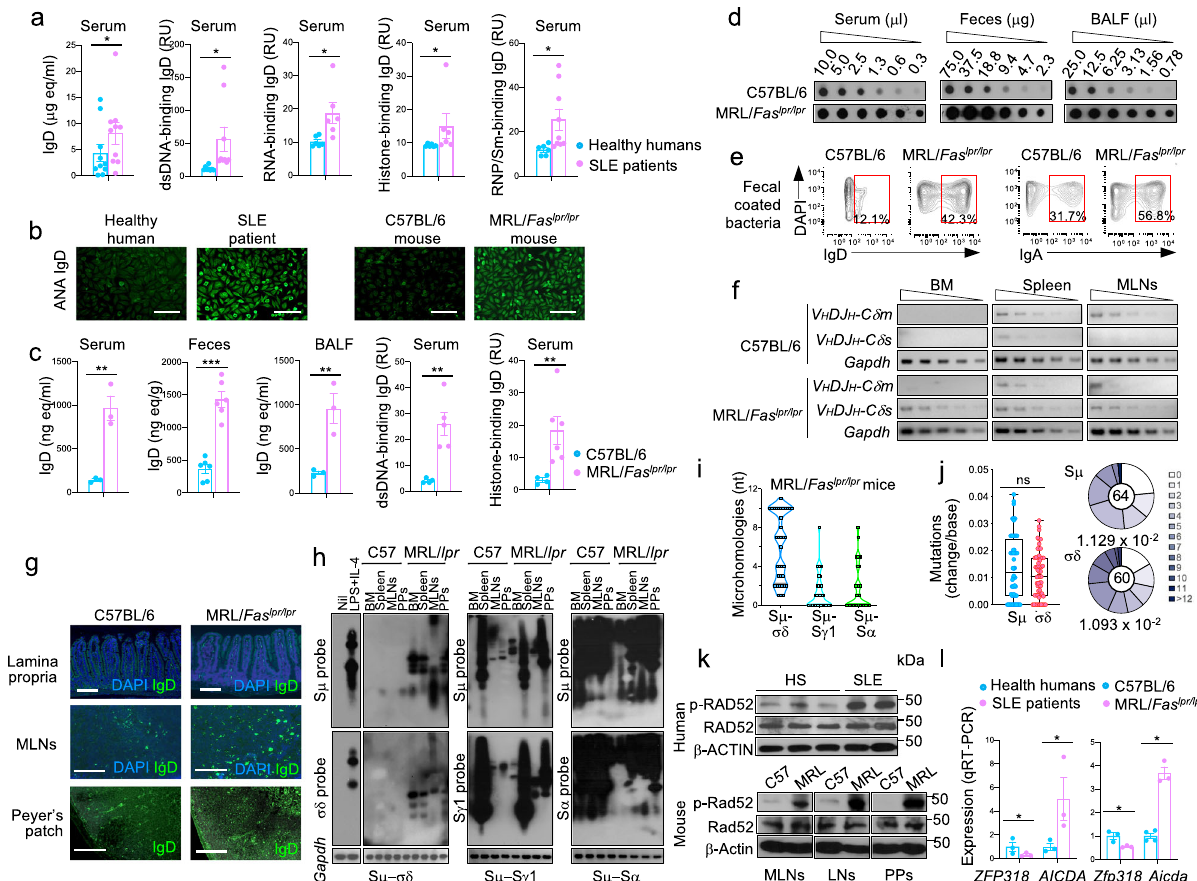
Fig. 10 p-Rad52 expression, CSR to IgD and antinuclear antigen IgD autoantibodies in lupus patients and mice. a Serum total and double-strand DNA (dsDNA)-, RNA-, histone-, or RNP/Sm-binding IgD in healthy human subjects and systemic lupus erythematosus (SLE) patients, as analyzed by speci fi c ELISAs. Each dot represents the datum from one individual human subject. Mean ± SEM of 6 – 10 healthy subjects or SLE patients are depicted. * p < 0.05 (unpaired two-tailed t -test). b Human and mouse antinuclear autoantibodies (ANAs), as visualized by indirect immuno fl uorescence microscopy on HEp-2 cells that were incubated with serum from a healthy human subject, an SLE patient, a C57BL/6 mouse, or a MRL/ Fas lp/lpr mouse, as revealed by FITC-labeled rat mAb to human or mouse IgD. Scale bar = 50 μ m. c Total IgD in serum, feces and BALF as analyzed by dot-blotting, and concentrations of IgD autoantibodies to dsDNA or histone in serum of C57BL/6 and MRL/ Fas lpr/lpr mice, as analyzed by speci fi c ELISAs. Each dot represents datum from one individual mouse. Data are mean ± SEM of 3 – 9 mice, as indicated. ** p < 0.01, *** p < 0.001 (unpaired two-tailed t -test). d IgD concentrations in serum, feces and BALF from C57BL/6 and MRL/ Fas lpr/lpr mice, as analyzed by dot-blots. Shown are dot-blots from one C57BL/6 and one MRL/ Fas lpr/lpr mouse, representative of 3 – 9 C57BL/6 and MRL/ Fas lpr/lpr mice. e Bacteria-bound IgD and IgA in feces from C57BL/6 and MRL/ Fas lpr/lpr mice, as analyzed by fl ow cytometry. f Expression of V H DJ H − C δ m, V H DJ H − C δ s, V H DJ H − C μ m , and V H DJ H − C μ s transcripts in bone marrow (BM), spleen and mesenteric lymph nodes (MLNs), as analyzed semi-quantitative RT-PCR by serial two-fold dilutions of cDNA templates. Shown are RT-PCR data from one C57BL/6 mouse and one MRL/ Fas lpr/lpr mouse, representative of three C57BL/6 and three MRL/ Fas lpr/lpr mice. g IgD + B cells in lamina propria, MLNs and Peyer ’ s patches (PPs) of C57BL/6 and MRL/ Fas lpr/lpr mice, as visualized by fl uorescent microscopy. Scale bar = 100 μ m. h Recombined junctional S μ – σδ , S μ – S γ 1, and S μ – S α DNAs in bone marrow, spleen, MLNs, and PPs B cells from C57BL/6 and MRL/ Fas lpr/lpr mice as analyzed by speci fi c nested PCR using forward I μ and reverse C δ , S γ 1 or S α primers, followed by Southern-blotting using indicated probes. Data are representative of three independent experiments. i S μ – σδ , S μ – S γ 1 and S μ – S α junctional DNAs in non-immunized MRL/ Fas lpr/lpr mice, as ampli fi ed by nested PCR and sequenced by MiSeq. The length and numbers of nucleotide overlaps (microhomologies) in S μ – σδ , S μ – S γ 1, and S μ – S α junctional DNAs are rendered by violin plots. Each dot represents a unique sequence ( n = 45 per group). j Somatic point-mutations in S μ and σδ regions abetting recombined S μ − σδ DNA junctions in IgD class-switched spleen B cells from three MRL/ Fas lpr/lpr mice. Mutations were identi fi ed in a 48 – 506 nt stretch of S μ or σδ regions in unique S μ – σδ DNA recombination sequences. Each dot represents an individual sequence. ns: not signi fi cant (unpaired two-tailed t -test). Box and whiskers plots show the median, quartiles, maximum, and minimum of mutation frequencies in S μ and σδ regions. In pie charts, the size of slices denotes the proportion of sequences with the same number of mutations and the gray hue denotes the number of point-mutations per sequence. Center of pie shows the total number of independent sequences analyzed. Below the pie charts is the overall mutation frequency (change/base). k Expression of phosphorylated Rad52 (p-Rad52), Rad52 and β -Actin proteins in peripheral blood B cells from healthy human subjects and SLE patients as well as B cells from C57BL/6 mice and MRL/ Fas lpr/lpr mice, as analyzed by speci fi c Western blotting using rabbit anti-p-Rad52 Ab or anti- β -Actin mAb — p-Rd52 (Y104) Ab detected endogenous levels of Rad52 protein only when phosphorylated at tyrosine 104. l Expression of ZFP318 and AICDA transcripts in B cells from healthy human subjects and SLE patients (left panel), as well as Zfp318 and Aicda transcripts in MLNs from C57BL/6 and MRL/ Fas lpr/lpr mice (right panel), as analyzed by speci fi c qRT-PCR. Data are mean ± SEM of three healthy human subjects, three SLE patients, three C57BL/6 mice, and three MRL/ Fas lpr/lpr mice. * p < 0.05 (unpaired two-tailed t -test). No adjustments were made for multiple comparisons. Source data are provided as a Source Data fi